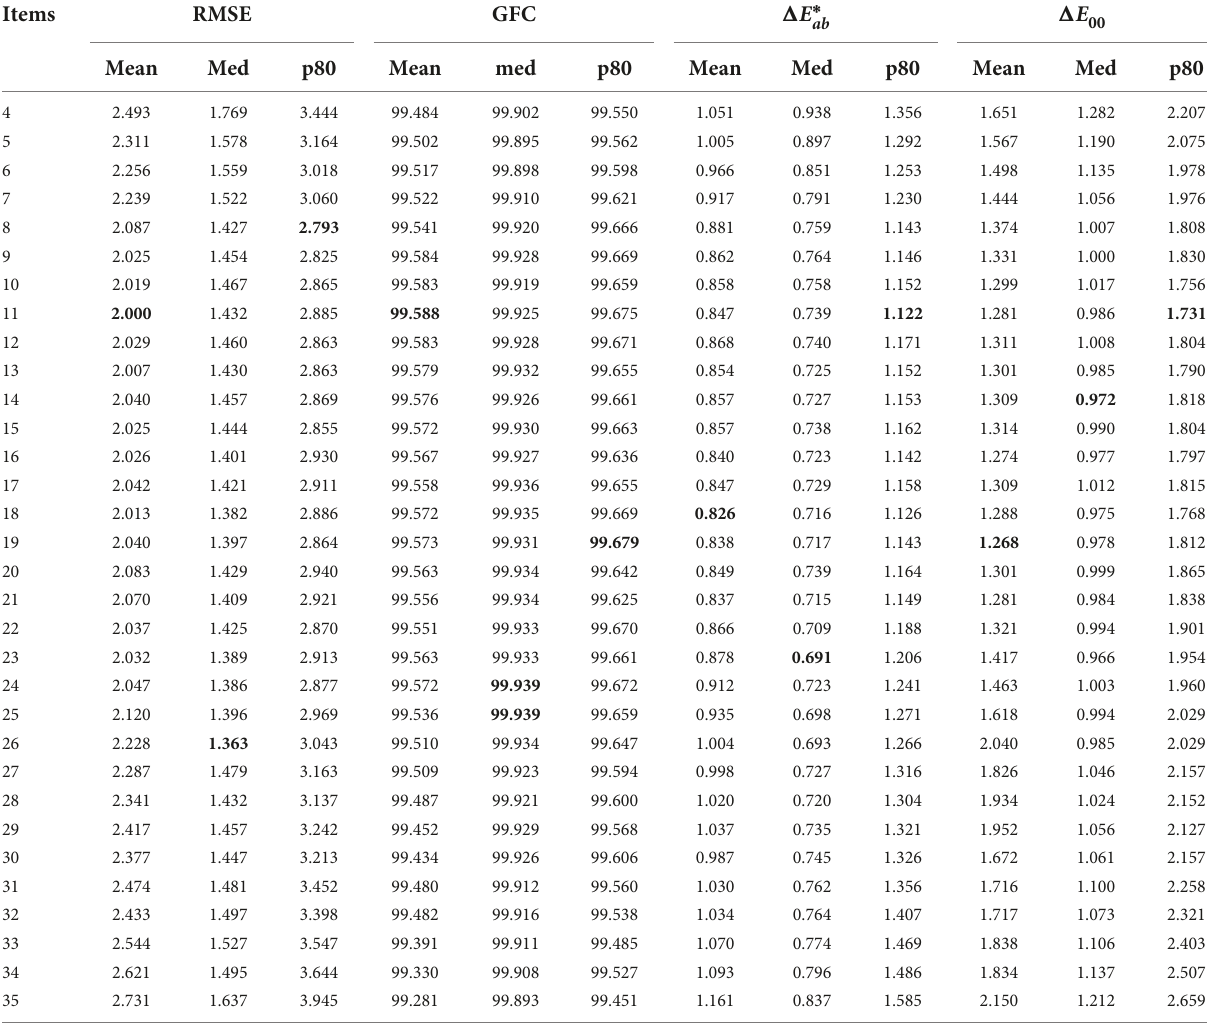
TABLE 4 The estimation accuracy of the proposed method spectral estimation method with the number of polynomial expansions from 4 to 35